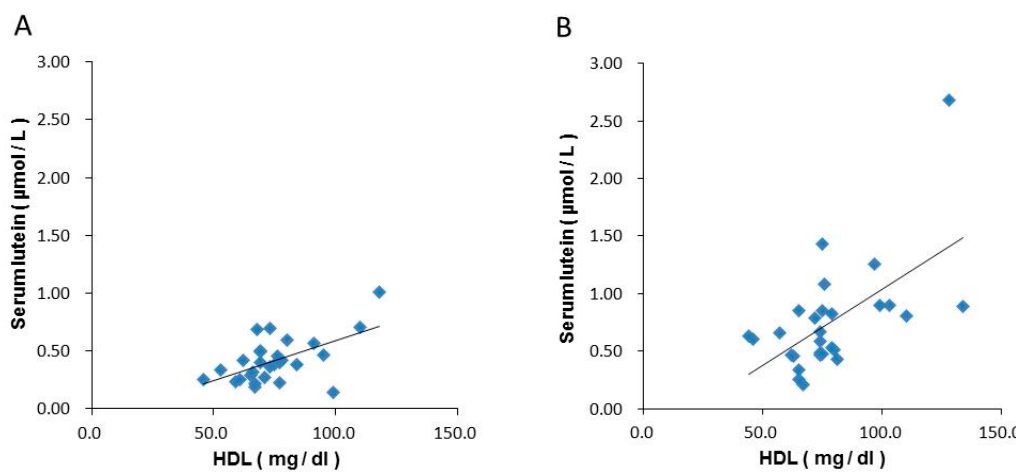
Figure 2. Correlations between blood HDL and serum lutein concentrations in the lutein group. ( A ): 0 w, ( B ): 16 w. HDL; High density lipoprotein cholesterol.